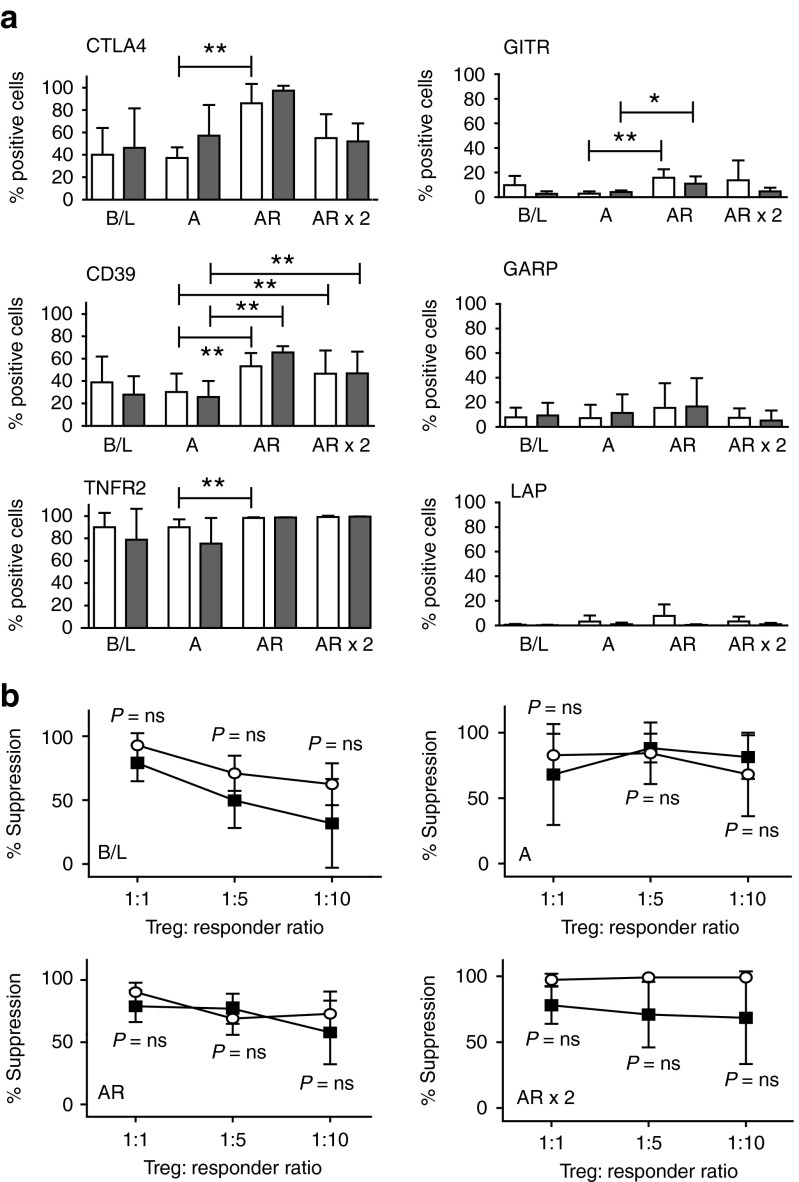
Lipopolysaccharide (LPS) does not impair allosuppressive phenotype or function of CD4+ regulatory T-cells (Treg) expanded after alloanergization. (a) Phenotype of expanded Treg after alloanergization and repeated exposure to alloantigen in the absence of presence of LPS. Bar charts show mean ±SD) frequencies of CTLA-4+, CD39+, TNFR2+, GITR+, GARP+, and LAP+ cells expressed as a proportion of CD4+ FOXP3+ Treg at baseline (B/L), after alloanergization (A) and after subsequent allorestimulation (AR). Data are for five to nine HLA-mismatched stimulator-responder pairs. *P < 0.05, **P < 0.01. (b) Allosuppressive function of CD4+ Treg at B/L, after alloanergization (A) and subsequent AR in the absence or presence of LPS. Mean percentage suppression (±SD) of alloproliferative responses of untreated responder cells by CD4+ Treg are shown. Data are for three to six HLA-mismatched stimulator-responder pairs. P values are for two-tailed t-tests, ns; nonsignificant.